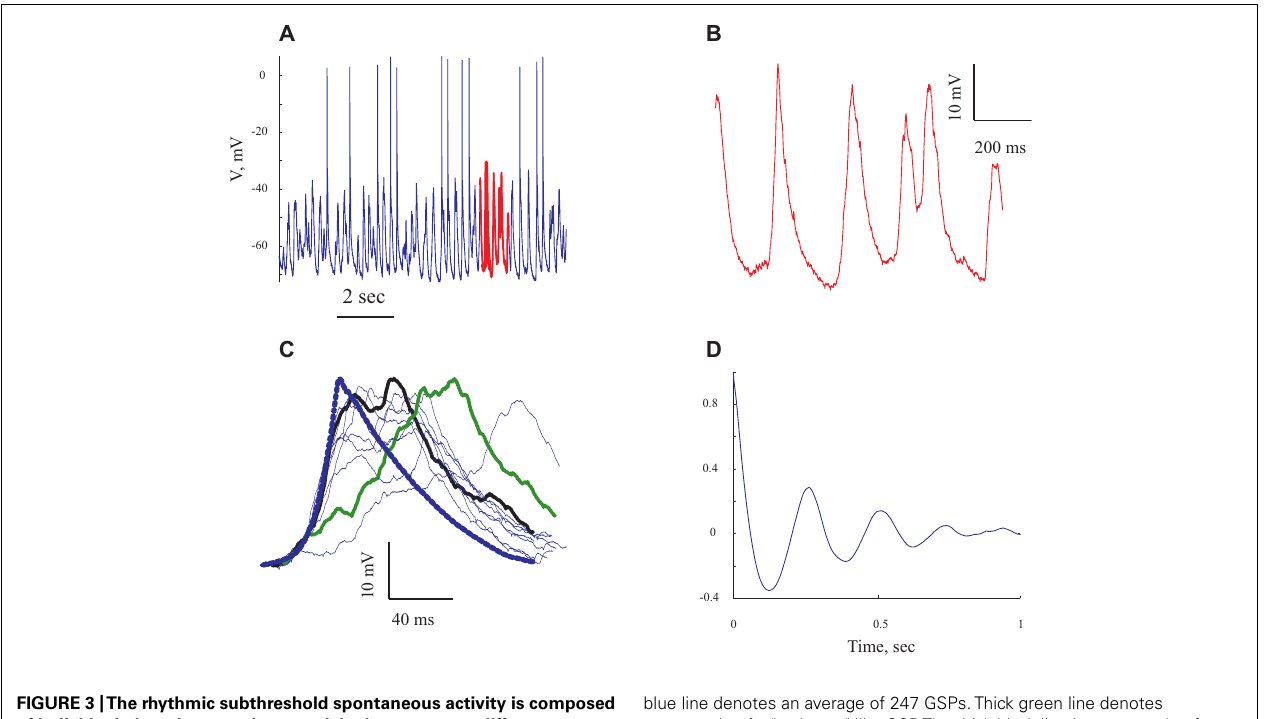
FIGURE 3 |The rhythmic subthreshold spontaneous activity is composed of individual gigantic synaptic potentials that appear at different degrees of synchrony. (A) A 10 s long voltage trace recorded at resting potential. (B) Expansion of the section marked in red in (A) . (C) The giant synaptic potential (GSP) time course.Thin lines denote single GPSs, thick